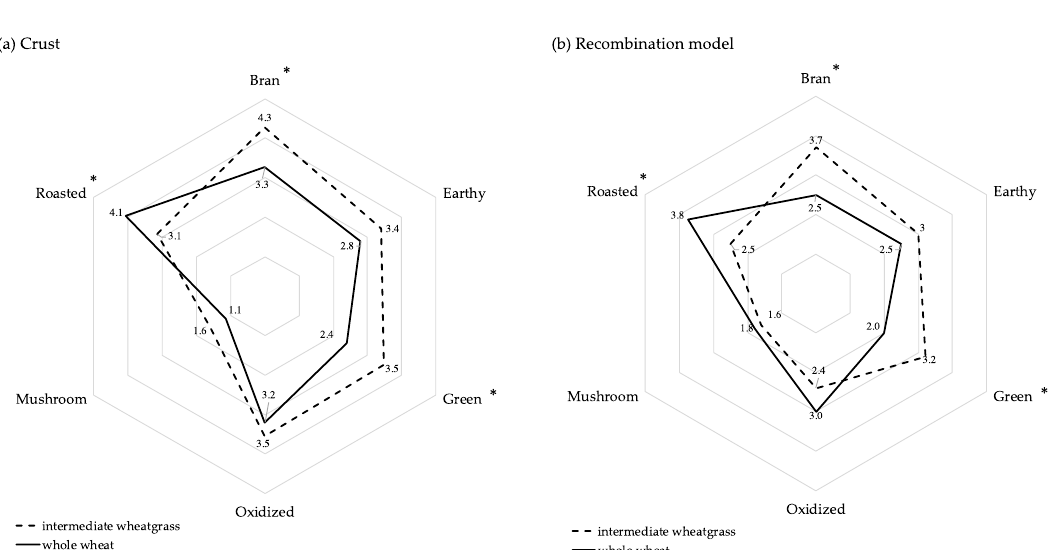
Figure 1. Aroma profiles from sensory descriptive analysis of whole wheat and intermediate wheatgrass (IWG) bread crusts ( a ) and aroma recombination models ( b ). * Indicates significant effect of sample on aroma intensity ( p < 0.05).